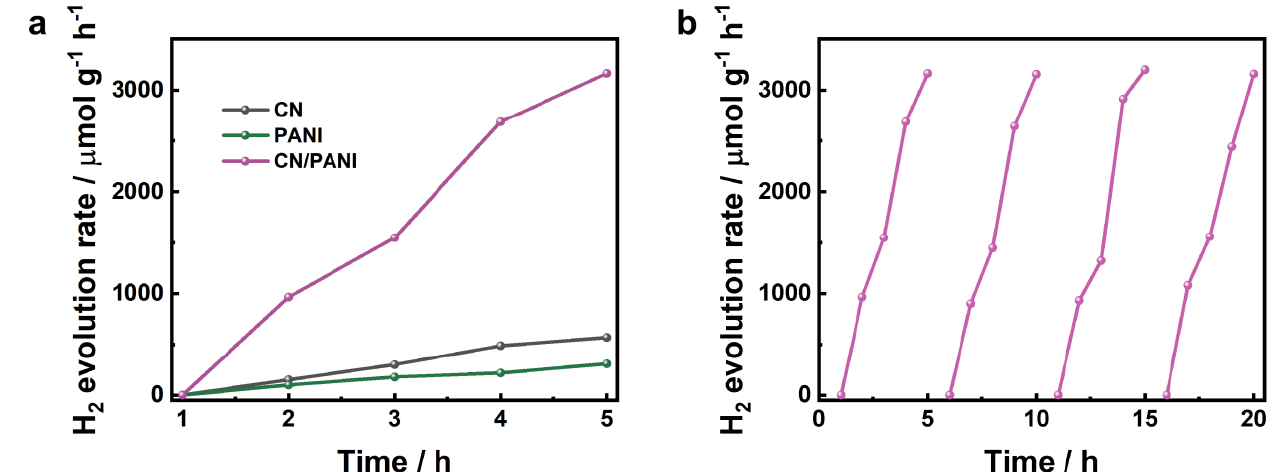
Figure 4. ( a ) Photocatalytic H 2 evolution rate of pristine CN, bare PANI, and the CN/PANI hetero- junction film. ( b ) Cyclic H 2 production tests of the CN/PANI heterojunction film.